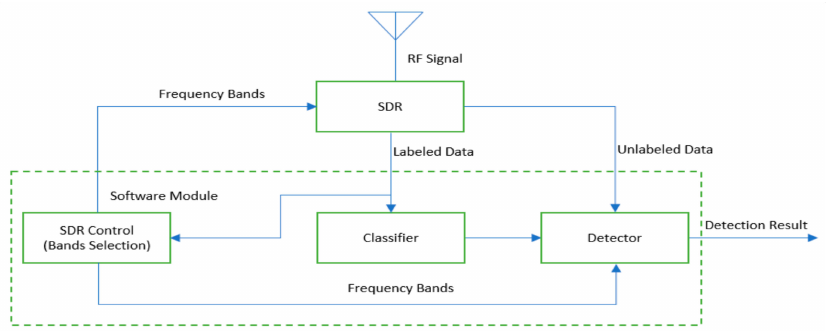
Figure 1. The cognitive radio human occupancy detection over RF analysis (CRhodora)